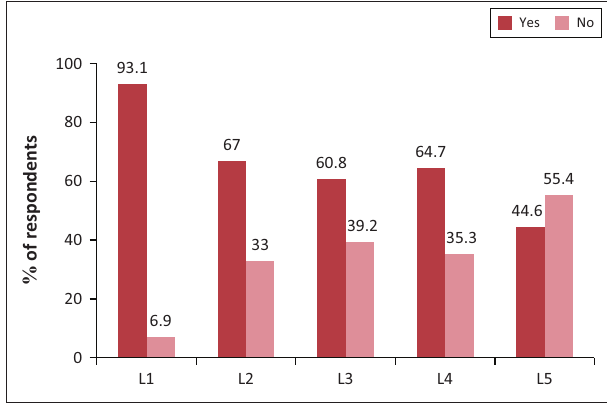
FIGURE 4: Value of